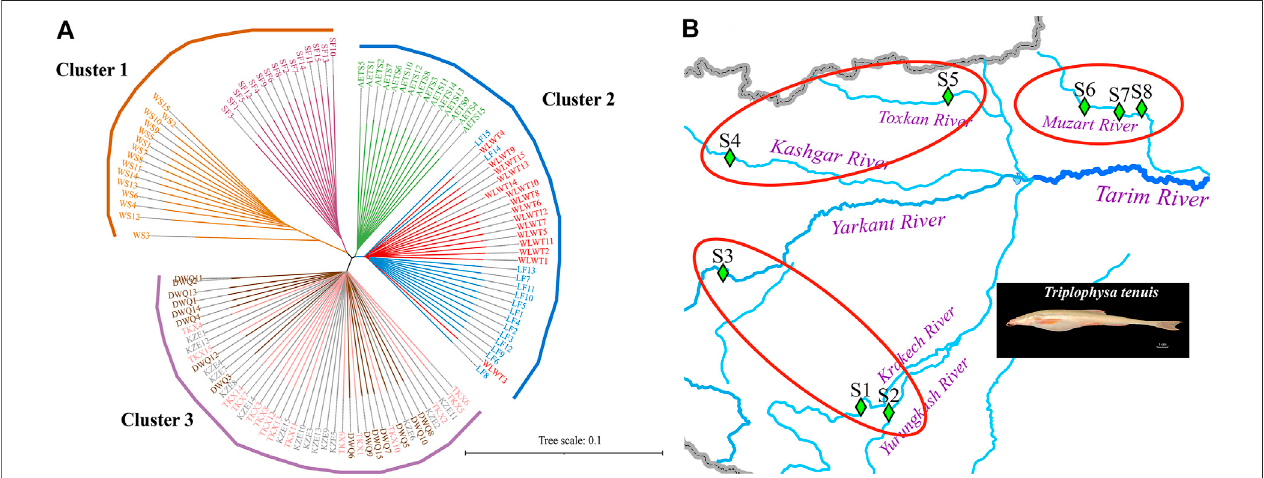
FIGURE 2 | Phylogenetic tree analysis of 8 T. tenuis populations. (A) Neighbor-Joining tree based on SNP data of 120 T. tenuis individuals. (B) Phylogenetic tree results corresponding to geographical location. The blue lines represent the rivers. The green square symbols indicate the sampling locations. S1, WLWF; S2, LF; S3,